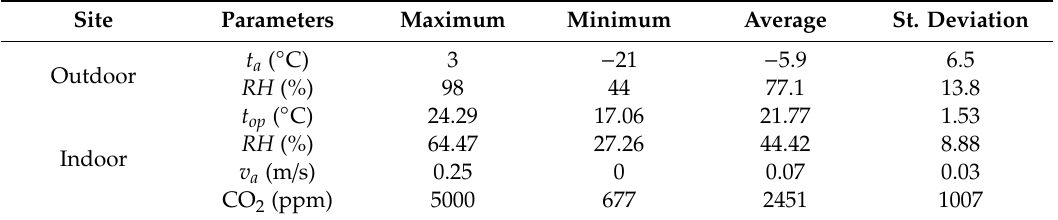
Table 4. Values of the outdoor and indoor environmental